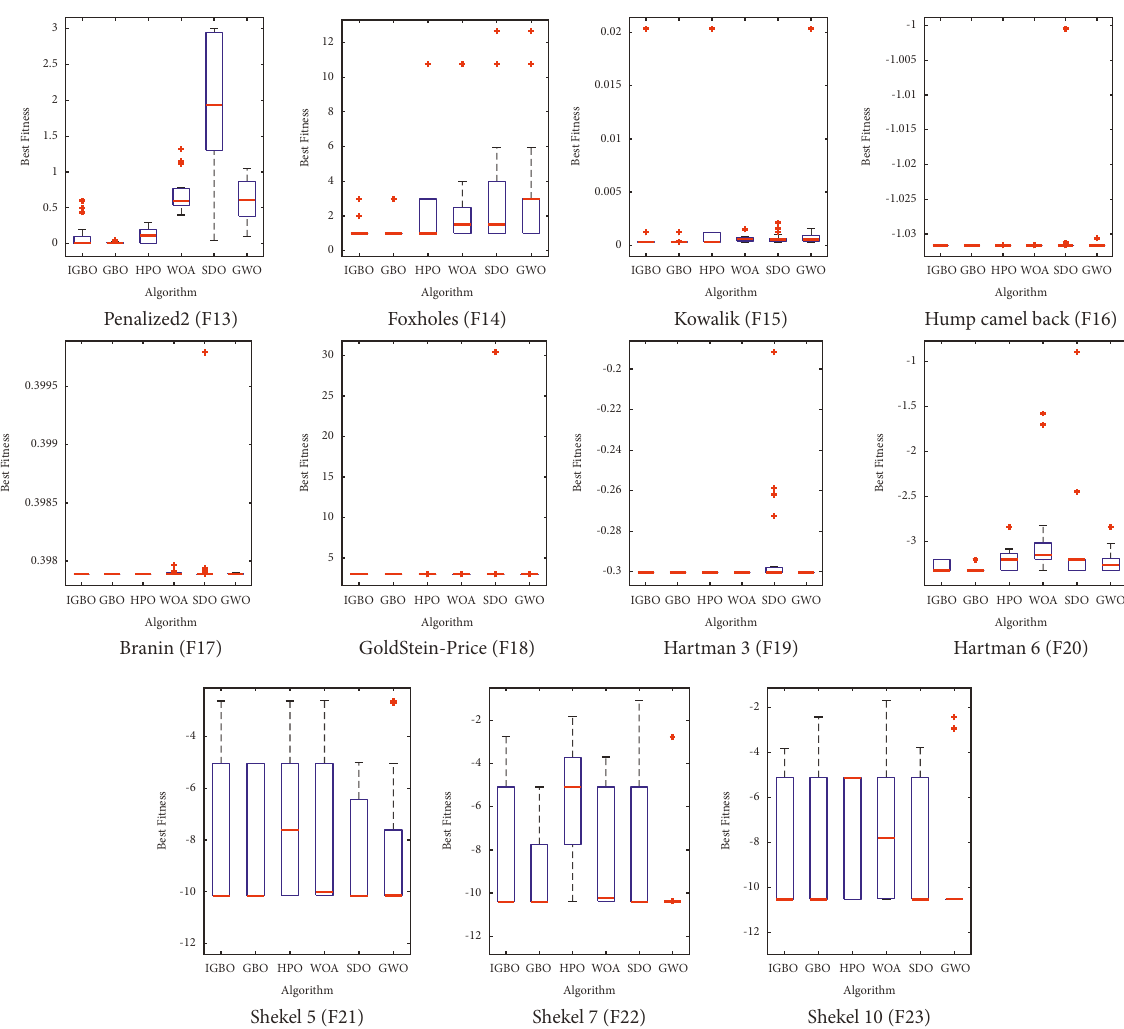
Figure 5: Boxplots for all optimization algorithms for 23 benchmark